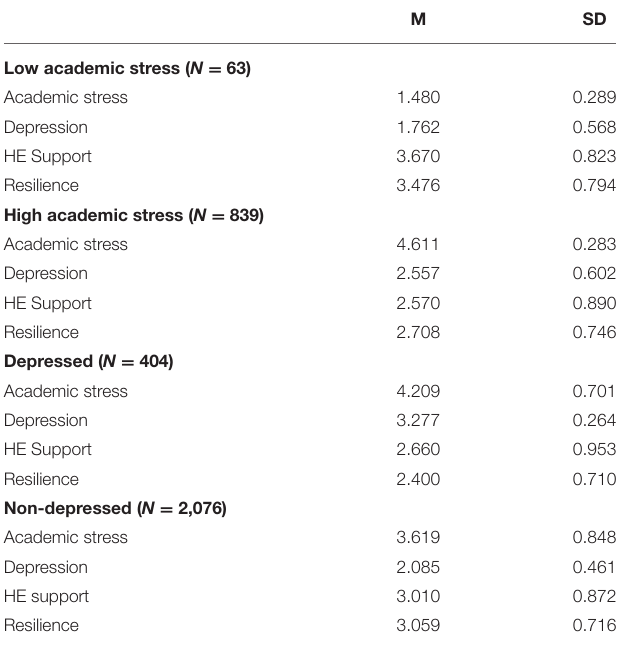
TABLE 3 | Descriptive statistics of the student subgroups on academic stress, depression, resilience, and HE support